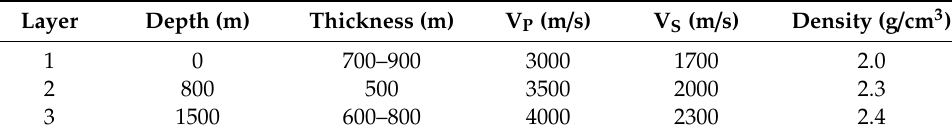
Figure 7. Curved layered TTI model, source, and observation system. The red star is the source; the blue dots are the detectors distributed on two survey lines (402 detectors in total, with 10 m spacing). Table 2. Media parameters for multi-layered TTI model.